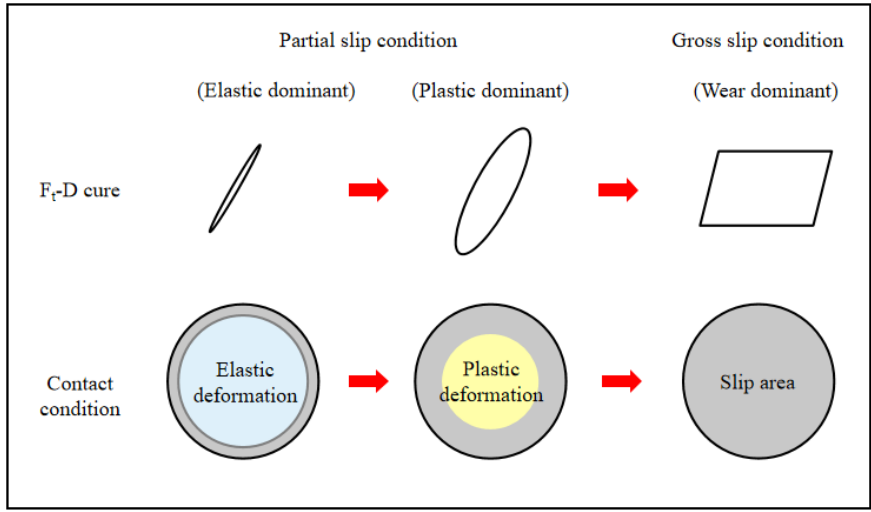
Figure 9. Schematic diagram of the evolution of contact states with different displacement amplitudes. The three-dimensional optical profilometry images of all the wear scars on the balls before and after treatment at different displacement amplitudes are displayed in Figure 10. The image displays the number of grooves on the ball surface after the wear tests, and the colors indicate the depth of the wear scar in each area, according to the scale. The greatest degree of wear generally existed in the central part of the wear scar. During the wear process, wear debris was squeezed out of the wear pits and accumulated on the contact edges of the wear region [41]. We observed that the maximum wear depth increased from 15 µ m to 50 µ m with the rise of the displacement amplitude from 10 µ m to 60 µ m (Figure 10a). When the displacement amplitude was less than 20 µ m, the wear scar was partially raised, with minor wear damage and residual wear debris in the crater. The wear profile was a regular elliptical shape at a displacement amplitude of 60 µ m, which was due to the fact that wear debris was discharged more easily from the wear scale.